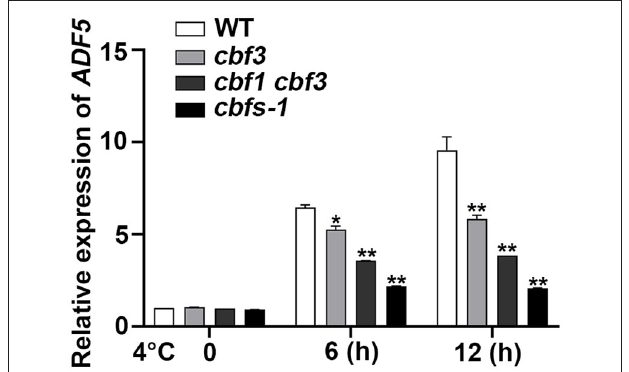
FIGURE 2 | ADF5 expression is induced by cold in WT, cbf3, cbf1/3 , and cbfs . Ten-day-old Arabidopsis seedlings were treated at 4 ◦ C for different durations, and the leaves were detached for RNA extraction. UBQ10 was used as an internal standard. Data presented are the means ± SD of three independent biological replicates (* P < 0.05; ** P < 0.01; Student’s two-tailed t